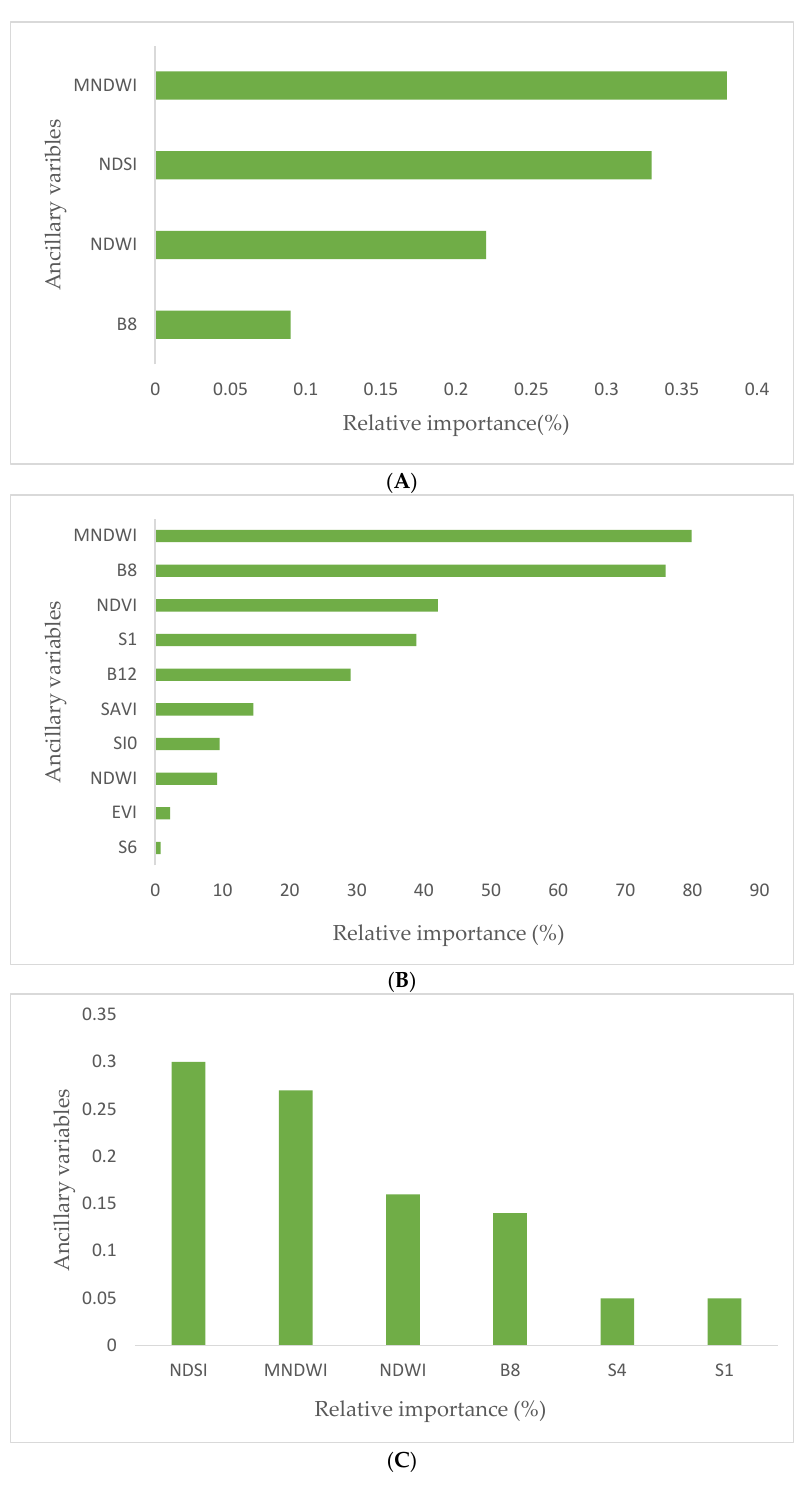
Figure 7. S2 ( A ) feature importance with RF; ( B ) feature importance with XGBoost; ( C ) feature importance with